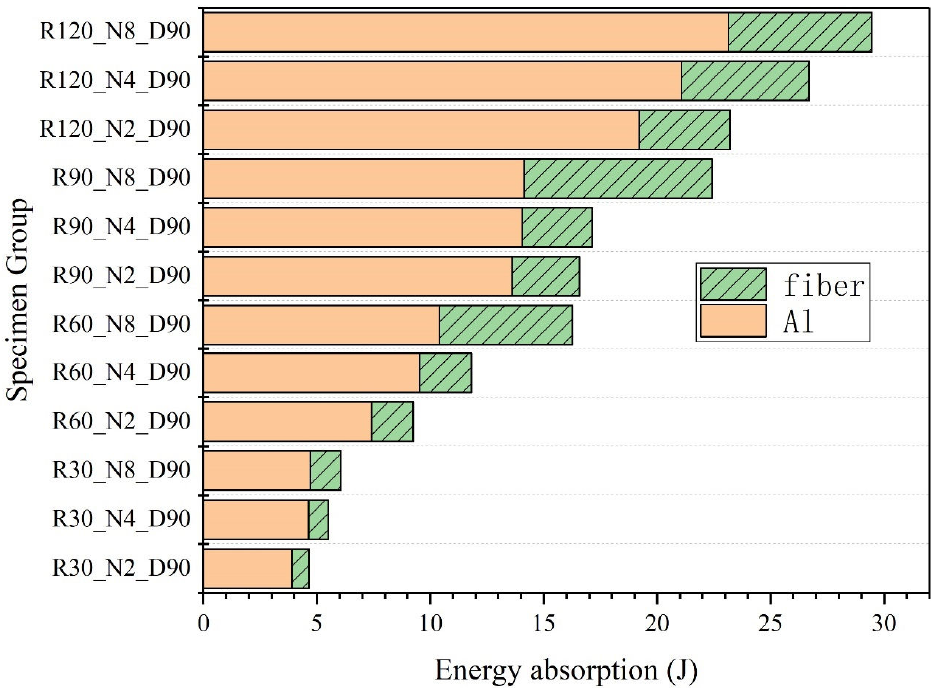
Figure 20. The influence of the number of layers on the energy absorption of each structure.